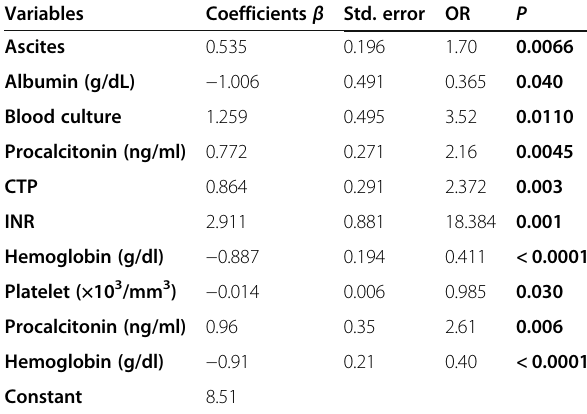
Table 4 Univariate and multivariate logistic regression analysis to determine predictors of bleeding in studied population ( n